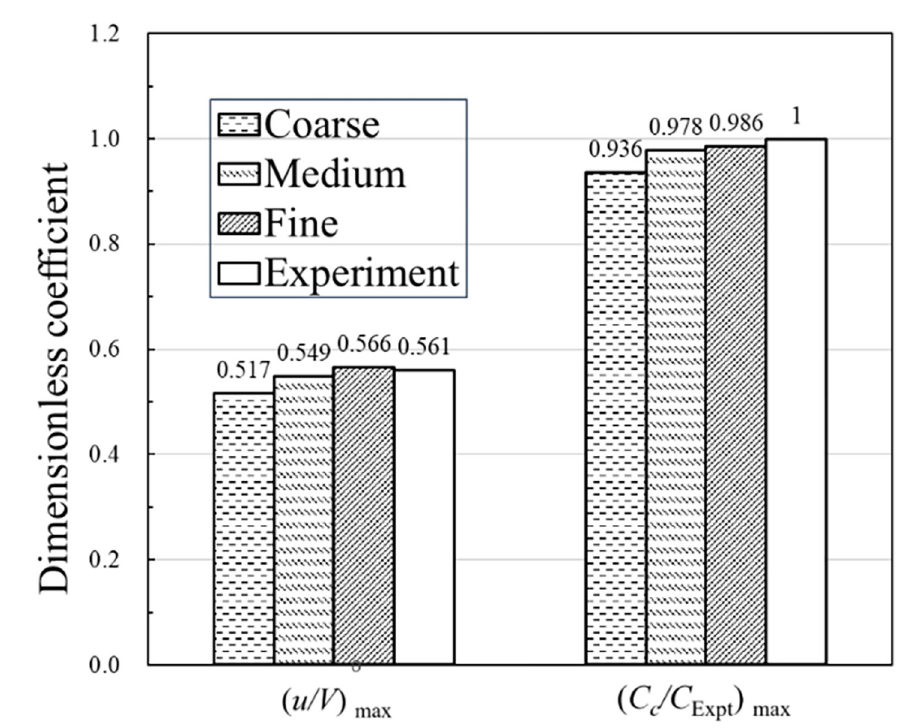
Fig 7. Validation of the results from the numerical calculation method.